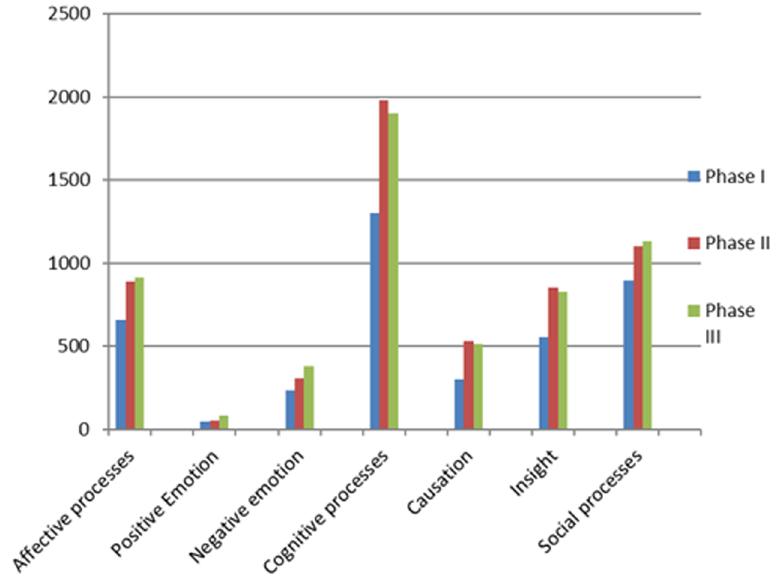
Figure 1. Number of words from mentalizing categories and subcategories in the three phases of